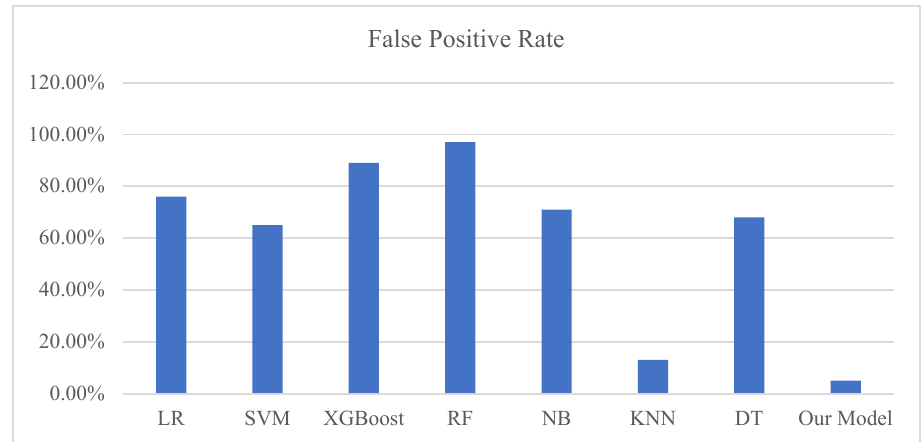
Figure 14. Comparison of the false positive rate with different algorithms.